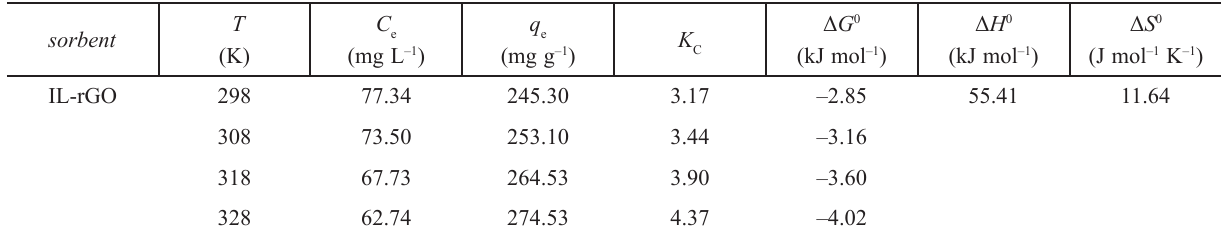
Table 3 – Thermodynamic parameters for sorption of chromate on IL-rGO sorbent (agitation speed = 250 rpm, sorbent dosage = 0.5 g L –1 , temperature = 298–328 K and pH 6.0) sorbent IL-rGO